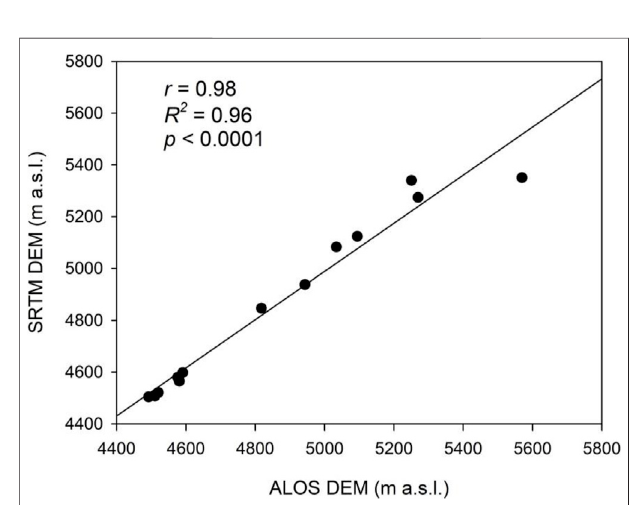
FIGURE 2 | Comparison of selected validation points in the Shuttle Radar Topography Mission (SRTM) and Advance Land Operation Satellite (ALOS) digital elevation models